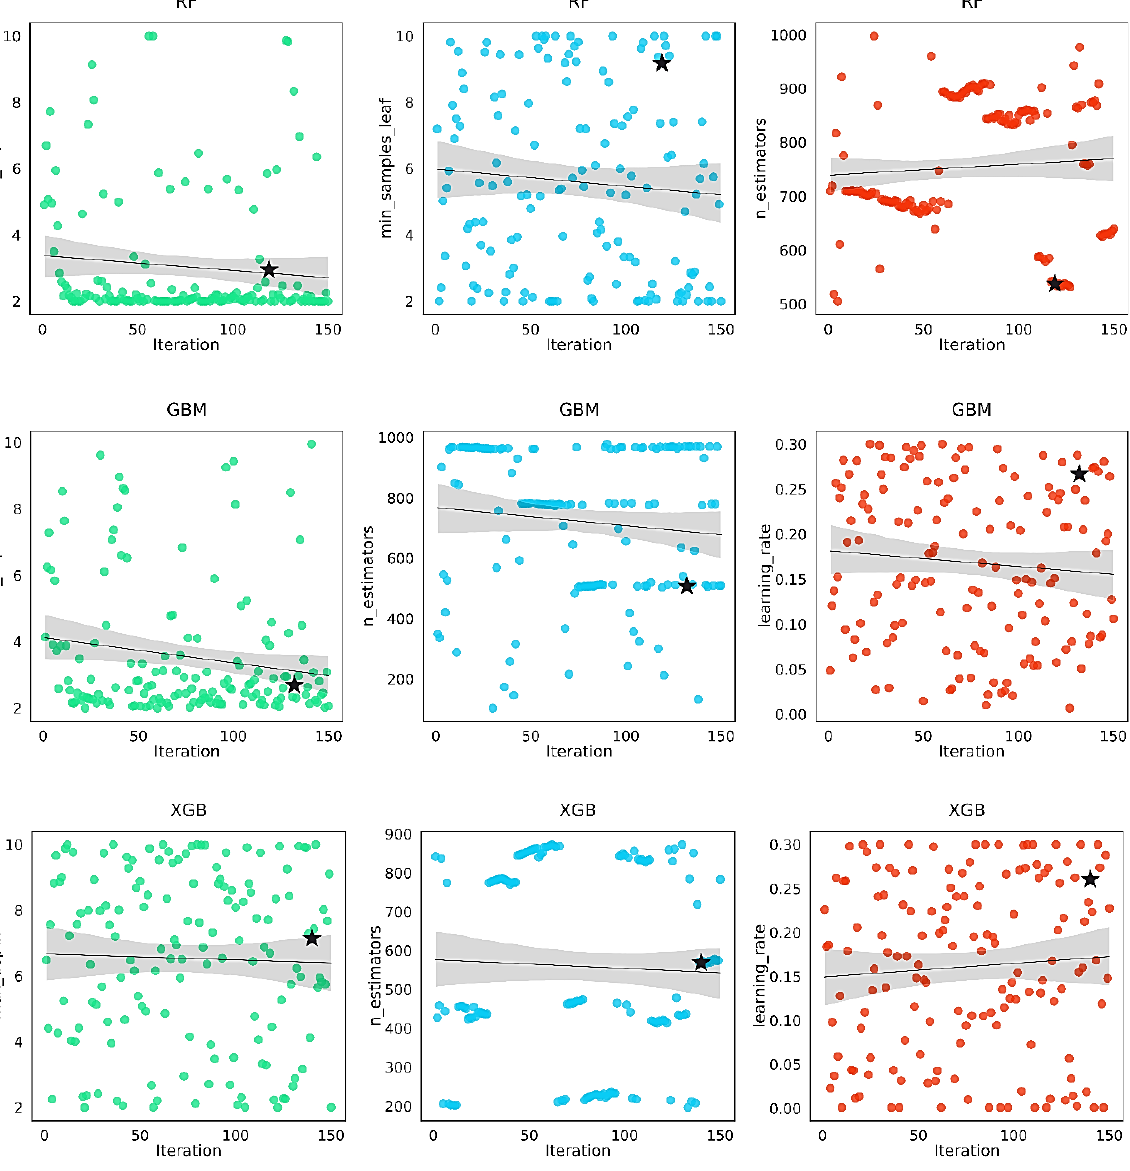
Figure 5 . Results of fine-tuning hyperparameters using Bayesian optimization.